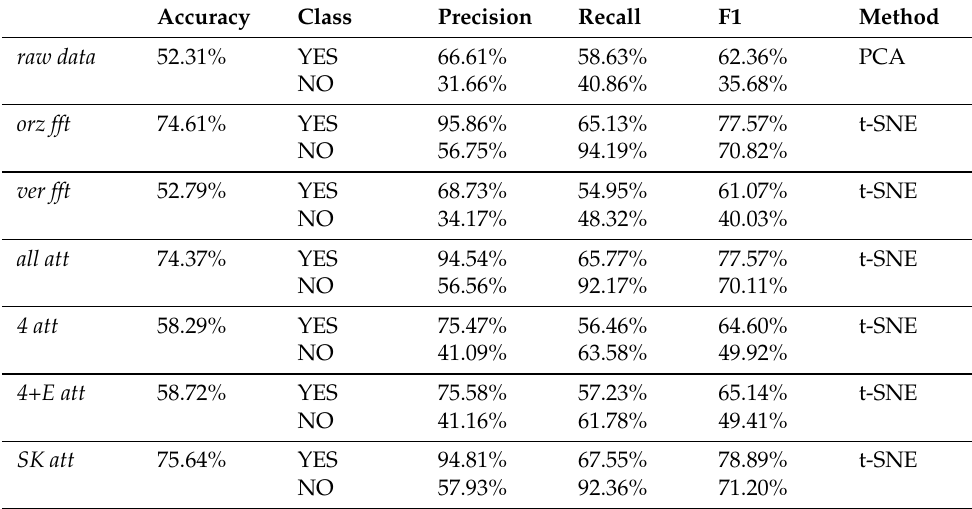
Table 6. K-Means—static case.